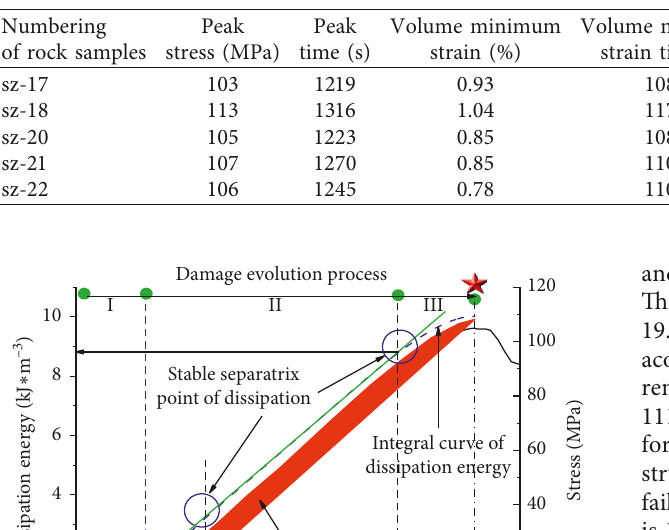
Table 2: Early warning table of body strain precursory information.